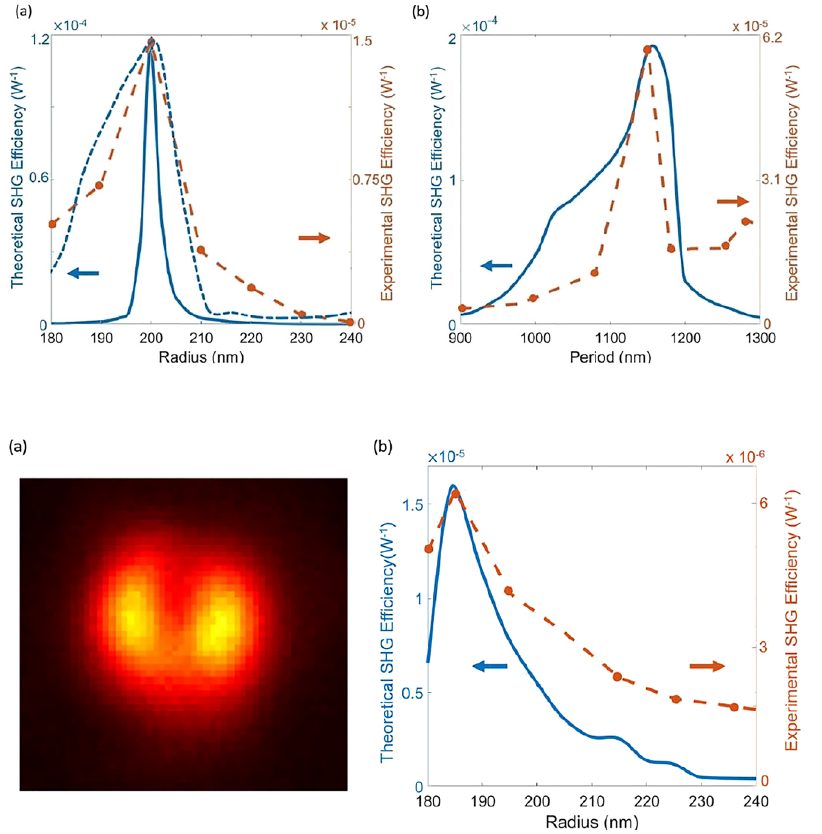
fi rming that Mie-resonances involved in the SHG pro-